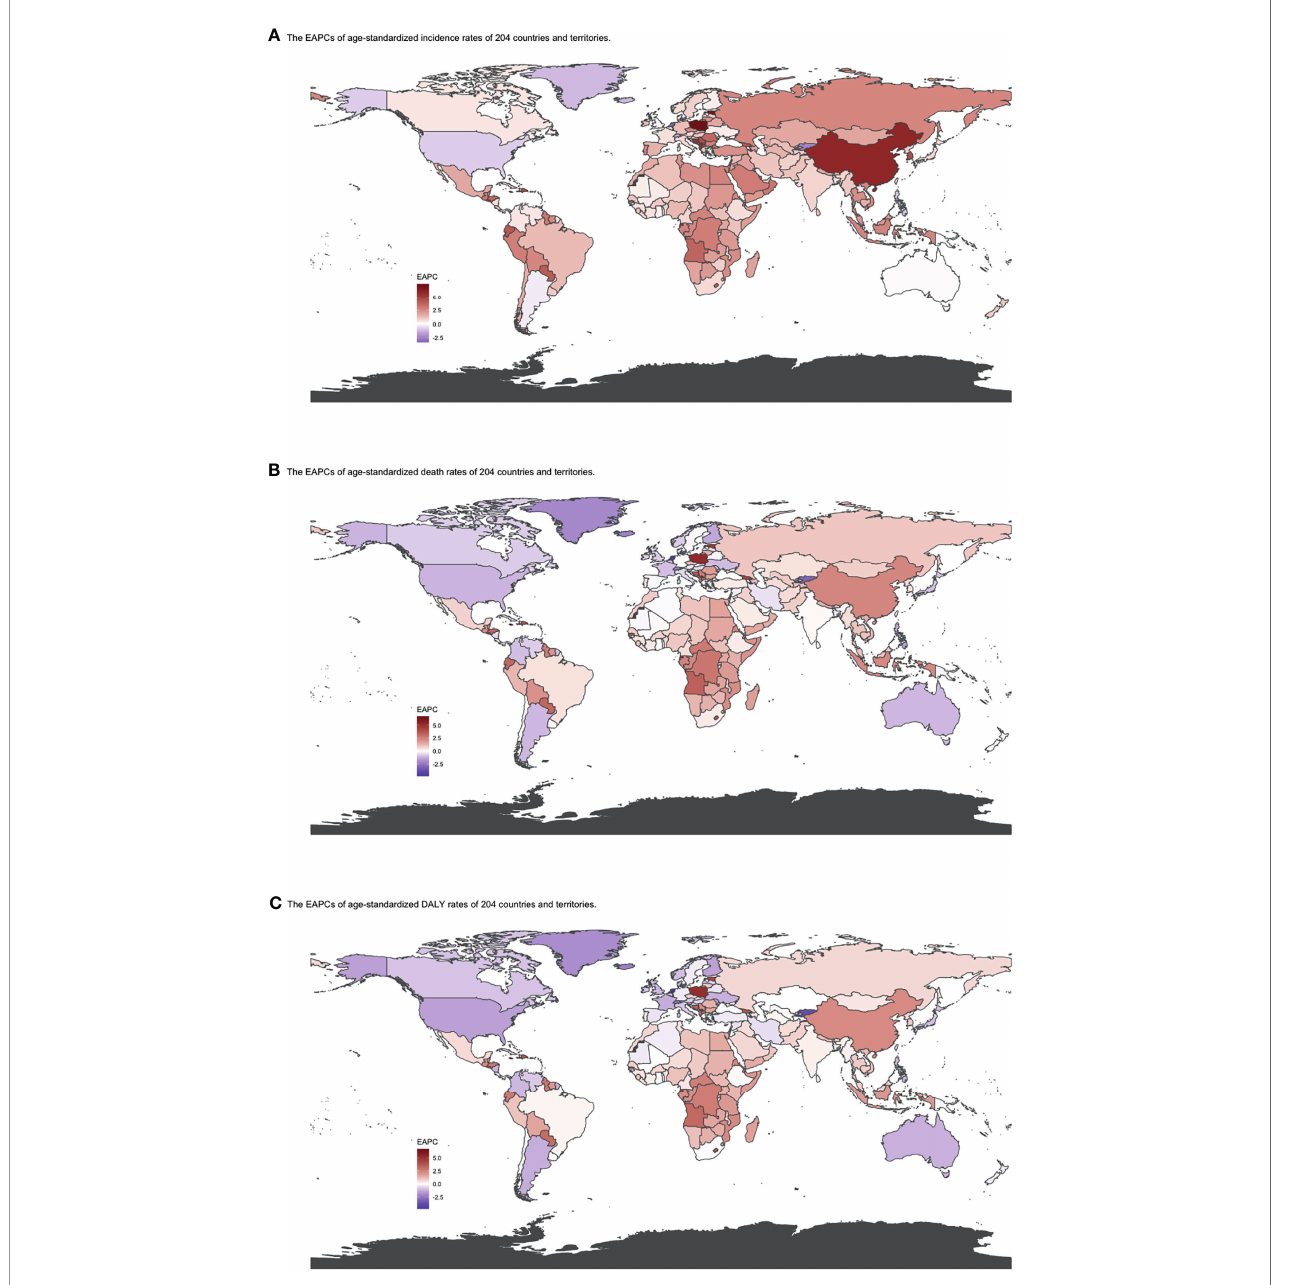
FIGURE 5 | EAPCs of (A) ASIR, (B) ASDRs, and (C) age-standardized DALY rates by country from 1990 to 2019. Heat gradient represents the change trends of EAPCs from red (highest) to blue (lowest). Blue indicates a downward trend and Red indicates an upward trend. (ASIR, age-standardized incidence rate; ASDR, age- standardized death rate; DALY, disability-adjusted life year; EAPC, estimated annual percentage